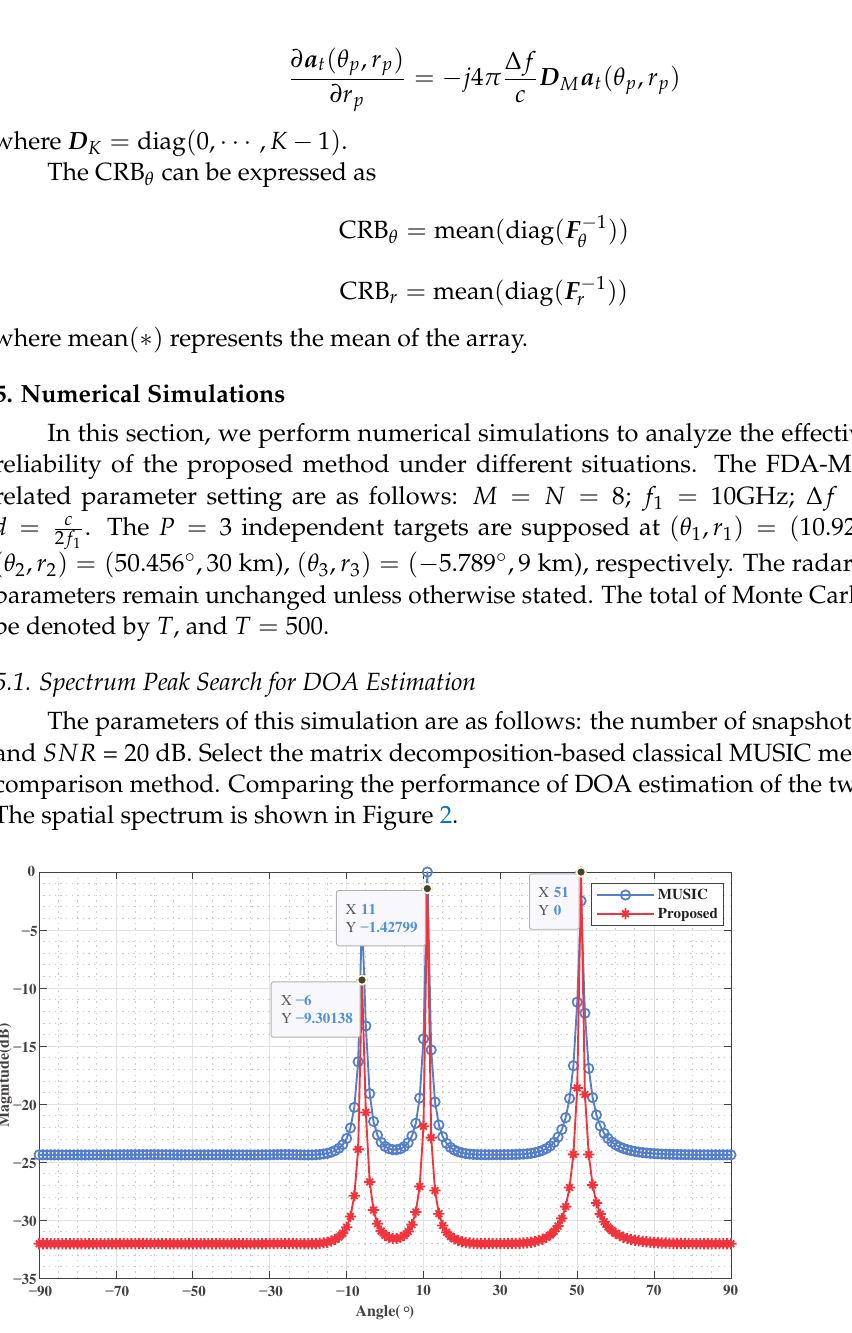
Figure 2. The spatial spectrum of angle